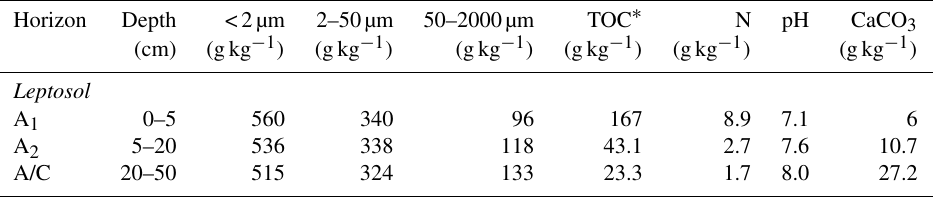
Table 1. Soil physicochemical characteristics at O3HP.